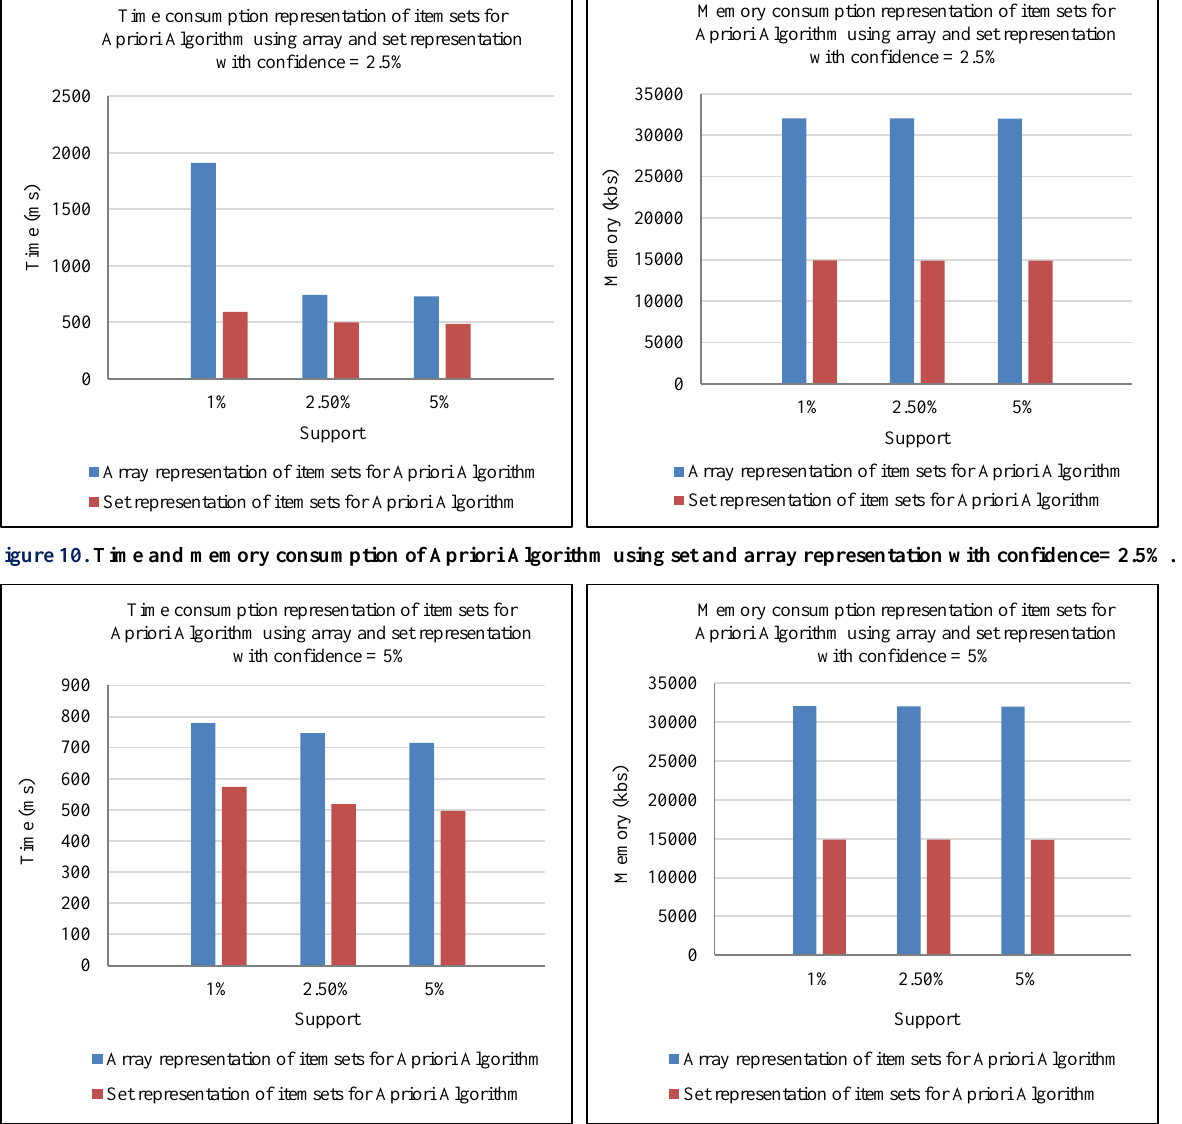
Figure 11. Time and memory consumption of Apriori Algorithm using set and array representation with confidence=